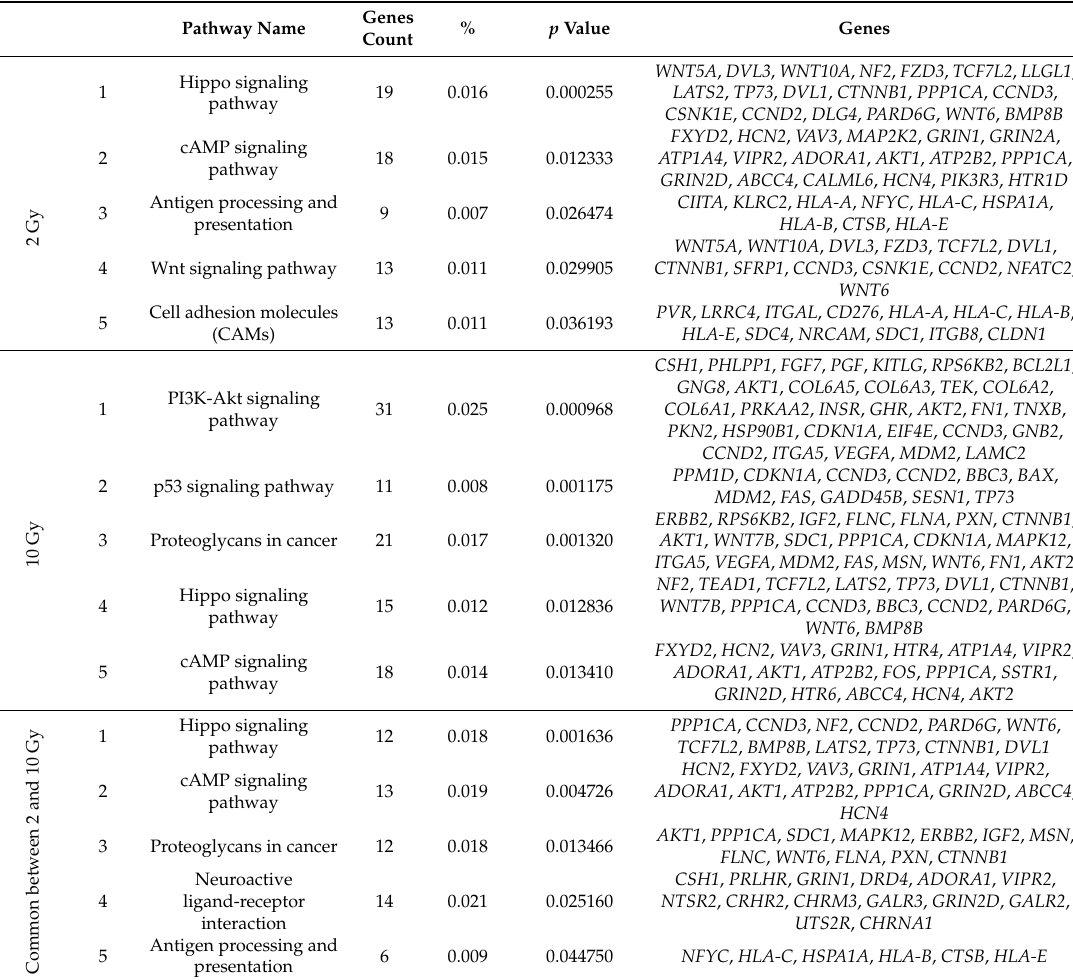
Table 6. Top-five statistically relevant pathways activated in U87 cells exposed to proton therapy